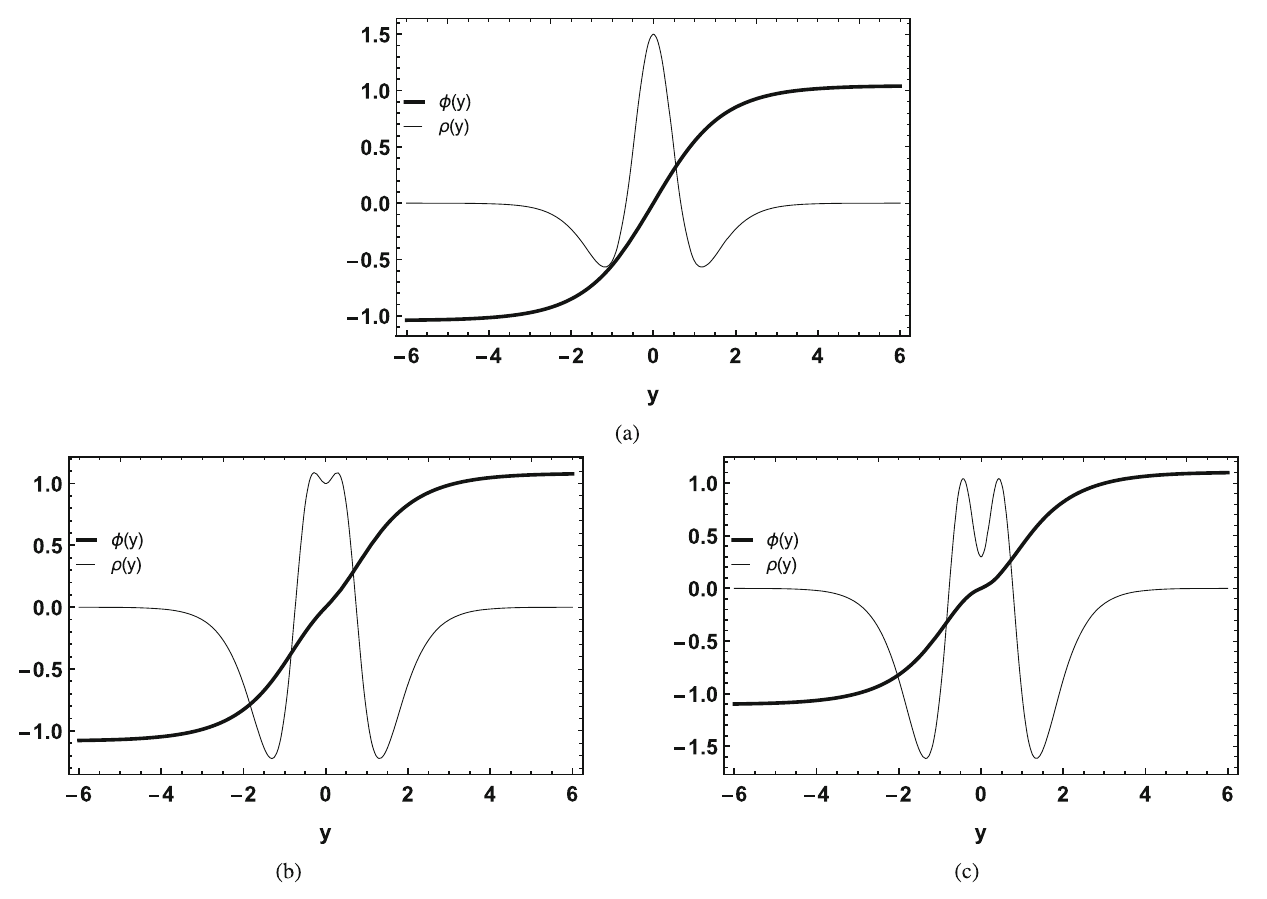
Fig. 1 Behavior of the solution of the scalar field and the energy density in the brane for n = 2 and p = λ = 1. a k = − 0 . 005. b k = − 0 . 09. c k = − 0 .